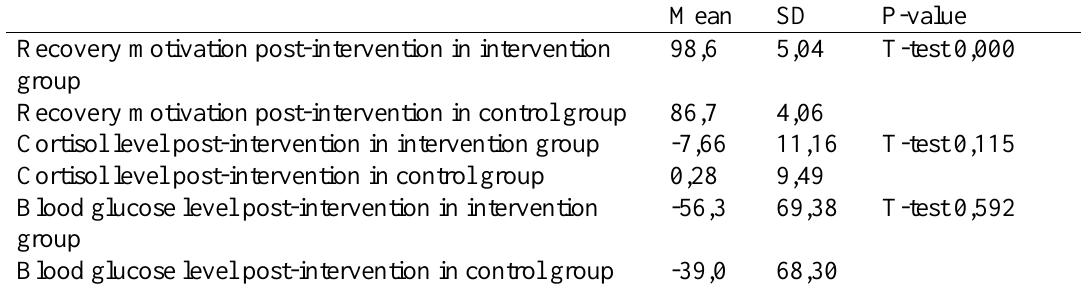
Table 3. Analyze result different (post-post) delta recovery motivation, delta cortisol level and delta blood glucose level in intervention group and control